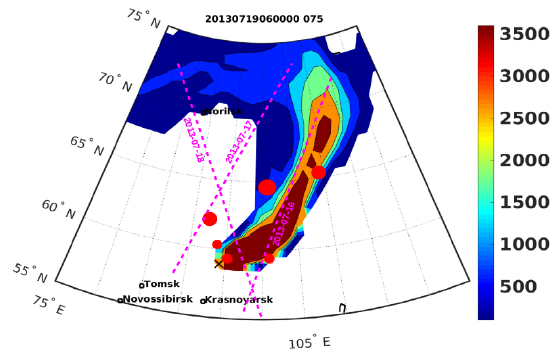
Fig. 7: Map of the PES distribution for FLEX- PART backward simulation for the aerosol layer at 1.7 km Fig. 6 (black cross). The red dots are FIRMS forest fires and the pink dotted lines are the selected CALIOP overpasses in the source area.